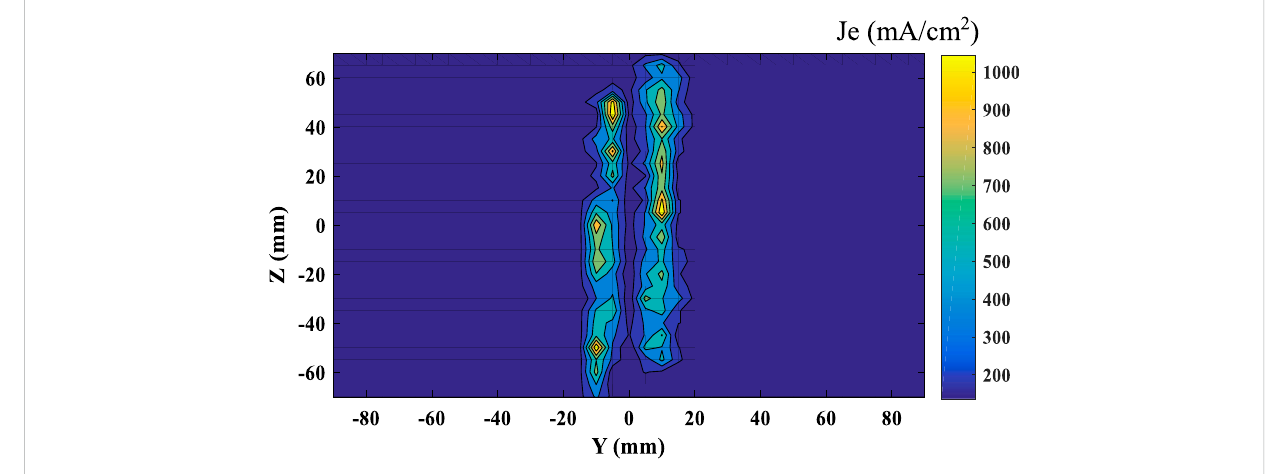
FIGURE 3 The current density distribution of electron beam emission on the